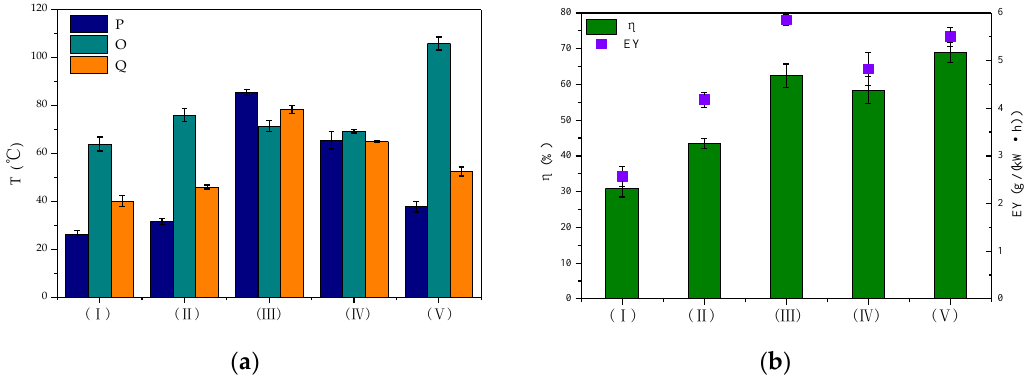
Figure 2. Toluene degradation in di ff erent reactors. ( a ) Changes in T; ( b ) changes in η and energy yield (EY).